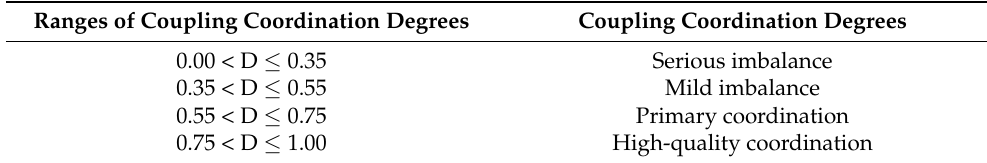
Table 3. Classification of coupling coordination